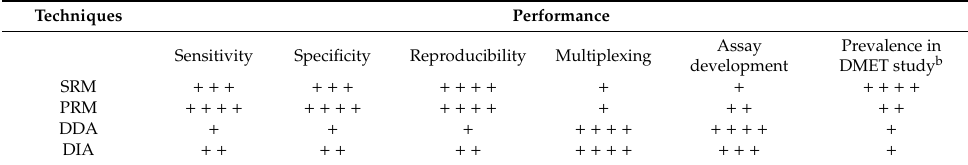
Table 1. Comparisons of the performance of selective reaction monitoring (SRM), parallel